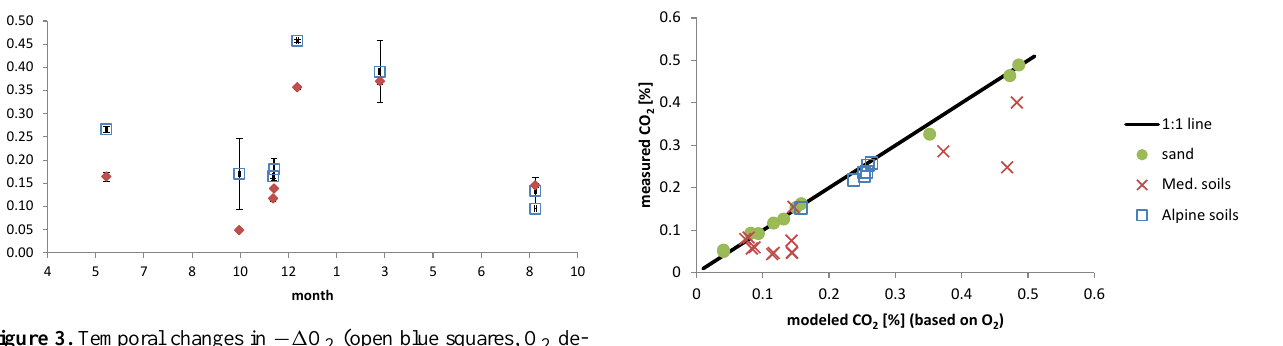
Figure 4. Diffusion in gamma-sterilized soils. For sand and alpine soils the measured CO 2 agrees well with the values calculated from O 2 concentration and the know diffusivity ratio, but this was not the case for Mediterranean soils, where measured CO 2 concentrations were lower than expected from O 2